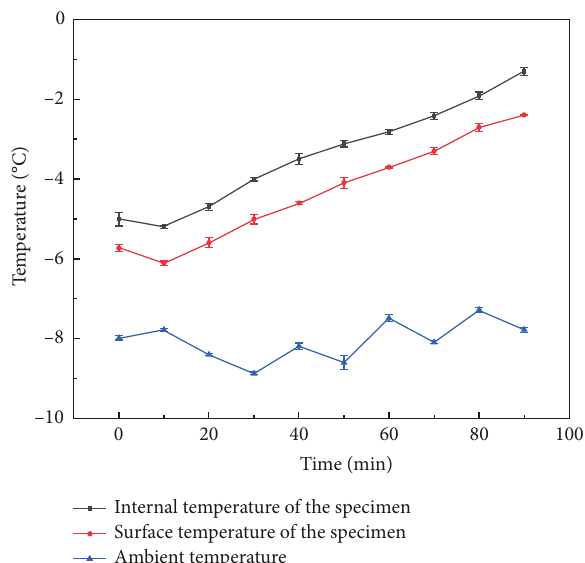
Figure 15: Heating effect of 0.5% carbon fiber +30% graphite rutting plate.